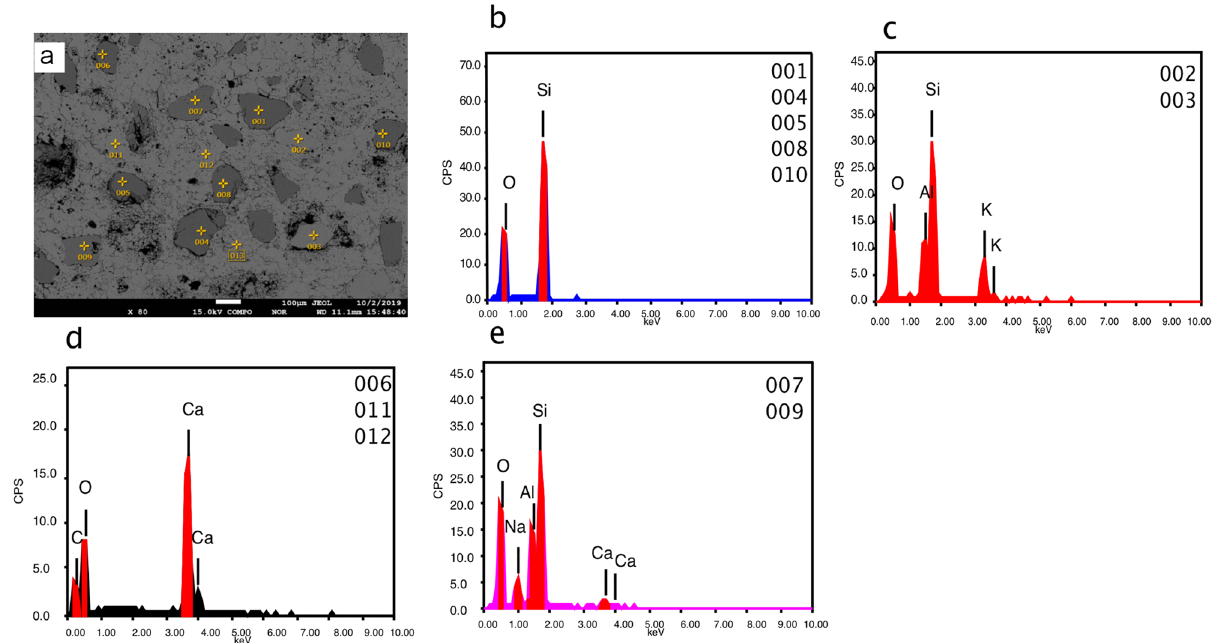
Figure 10. EPMA single point analyses of MV3 sample. ( a ) backscattered electron image of the calcitic matrix with clastic grains. The EDS chemical analysis shows the elemental composition of: ( b ) Quartz (points 001, 004, 005, 008, 010, 008), ( c ) silicates- K feldspar (points 002 and 003), ( d ) calcite (points 006, 011, 012), and ( e ) silicates- plagioclase (points 007 and 009). Neither dolomite nor salt traces were perceived. Point